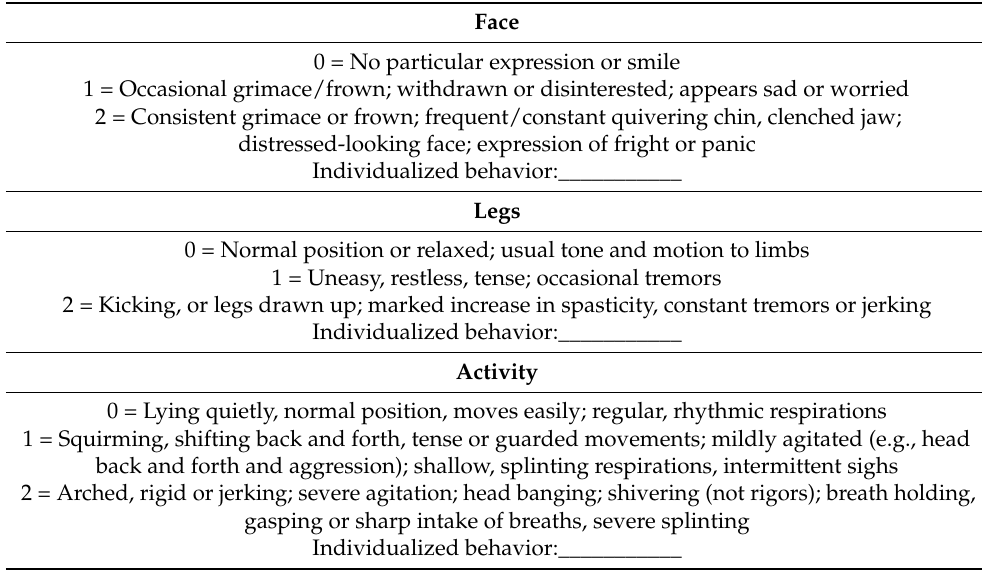
Table 1. Revised Face, Legs, Activity, Cry, Consolability (R-FLACC) scale (from Malviya et al. The revised FLACC observational pain tool: improved reliability and validity for pain assessment in children with cognitive impairment. Paediatr Anaesth. 2006; 16(3):